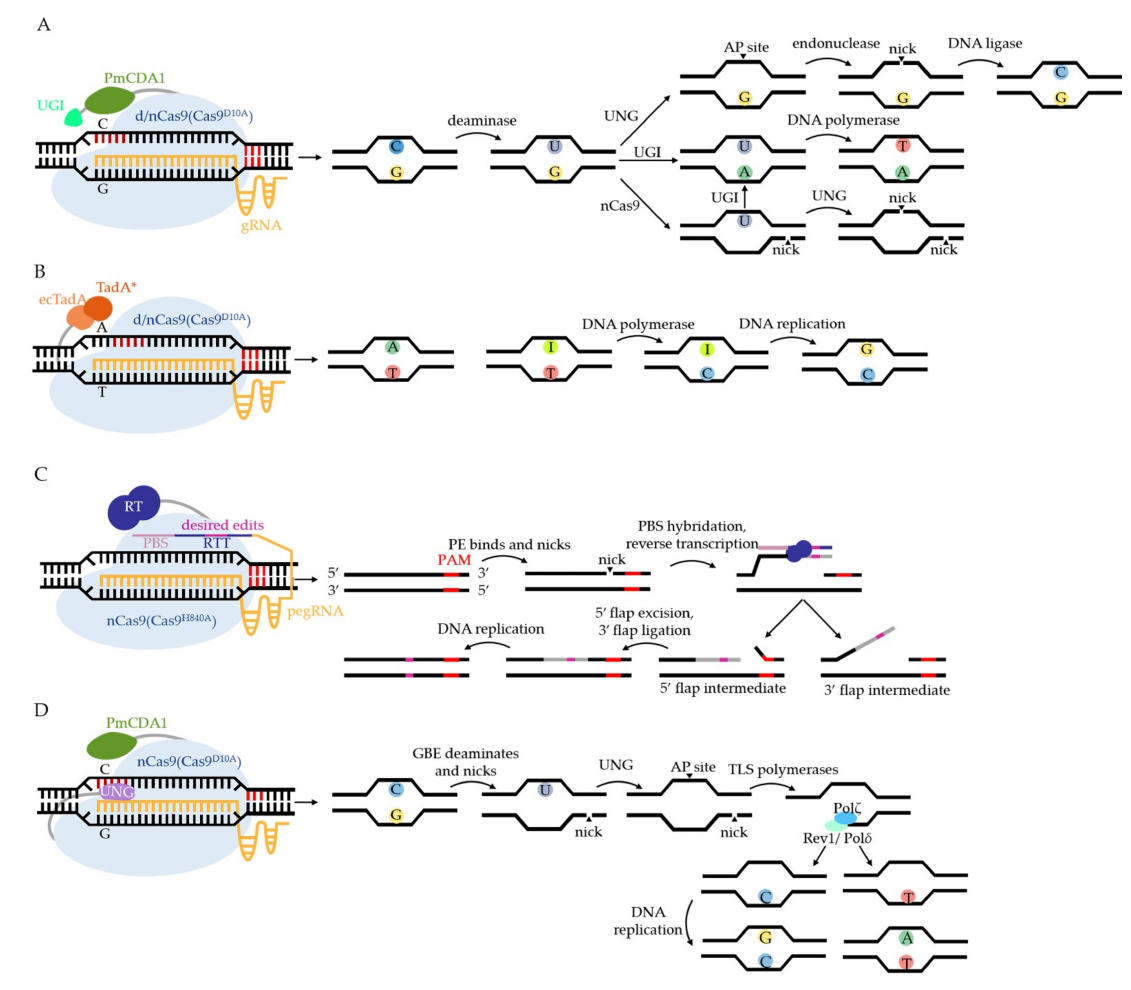
Figure 3. The basic components and working mechanisms of CRISPR-mediated base editing